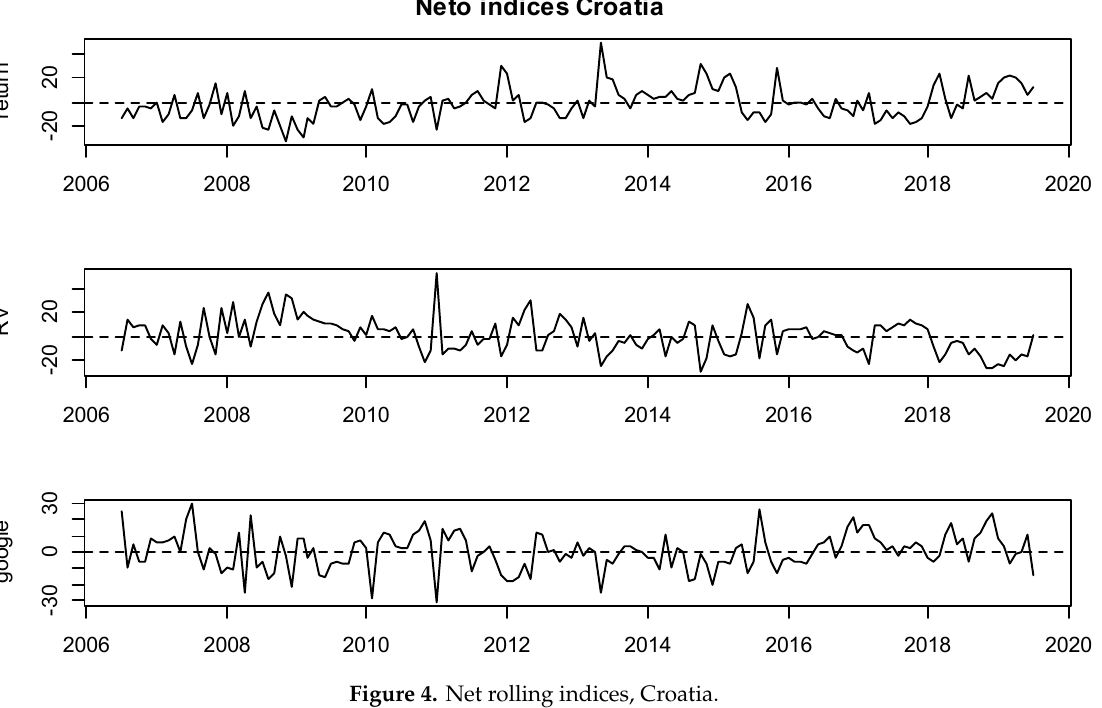
Figure 4. Net rolling indices, Croatia.